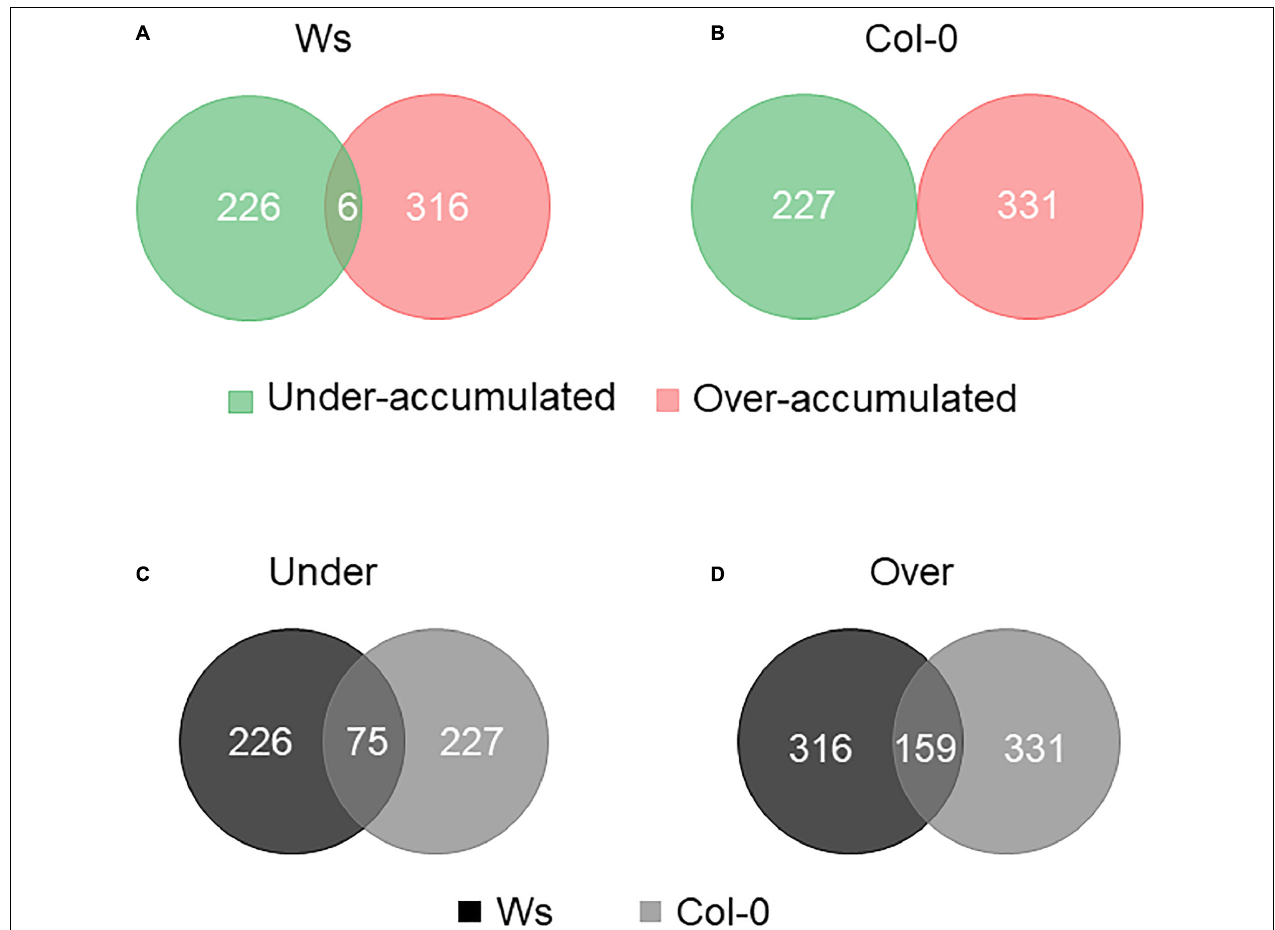
FIGURE 5 | Venn diagram of differentially accumulated proteins (DAPs) in salt-treated Ws (A) and Col-0 (B) shoots. Number of common underaccumulated (C) and overaccumulated (D) proteins between Ws and Col-0 salt-treated shoots.